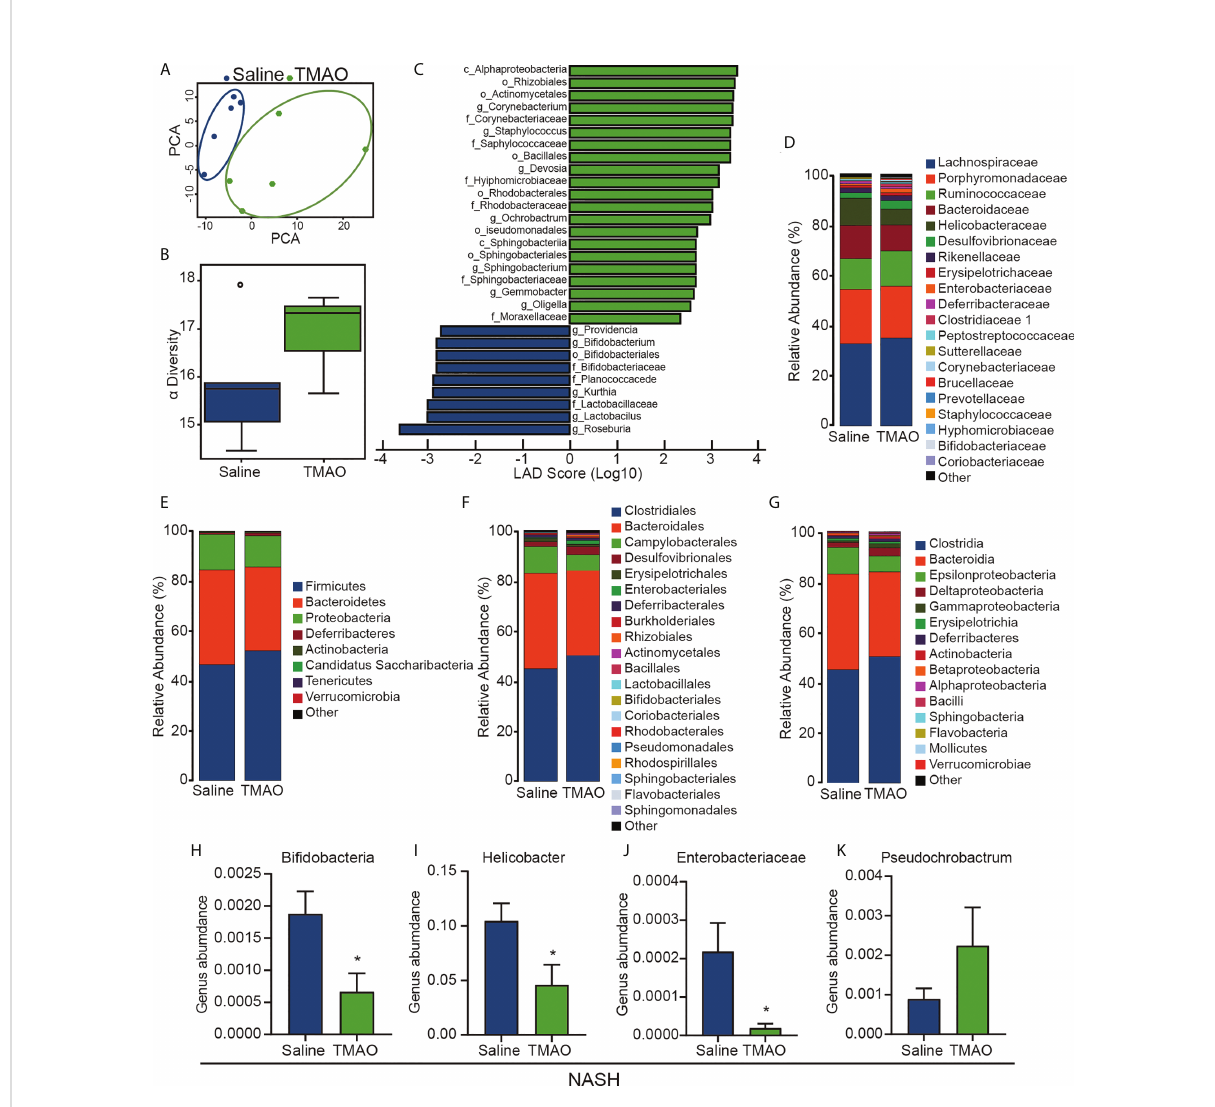
FIGURE 2 TMAO restores the diversity of the gut microbiota in NASH (A) PCA of the fecal microbial community among NASH and NASH-TMAO (n=5). (B) The alpha diversity of the gut microbiota (n=5). (C) Linear discriminant analysis coupled with effect size measurement analysis. (D – H) The differences between the two groups at the phylum, family, order and class levels. (I – K) Relative abundances of the genera Pseudochrobactrum , Bi fi dobacteria , Helicobacter and Enterobacteriaceae .